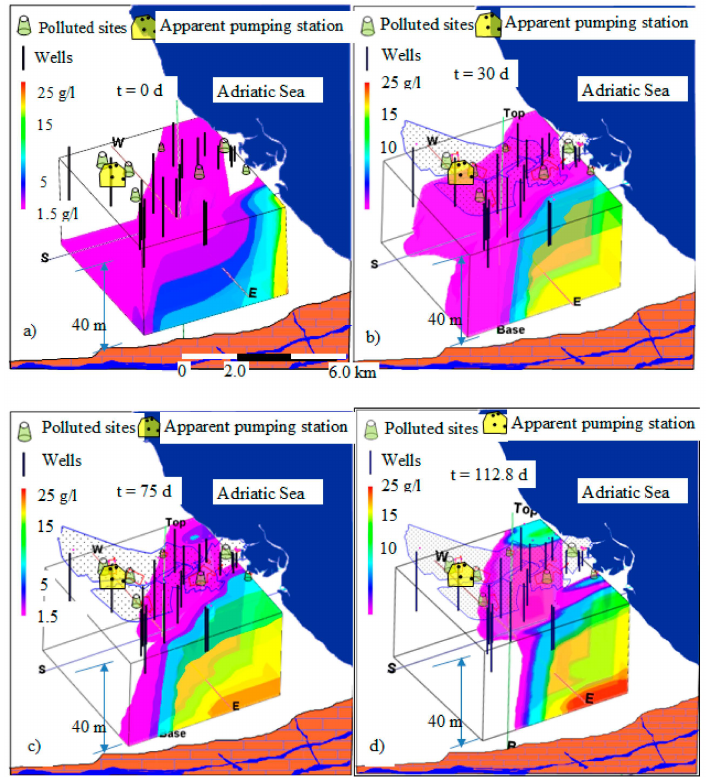
Figure 8. ( a ) 3D map of groundwater salinity during winter 2012 ( t = 0 day) and its comparison with groundwater salinity maps after ( b ) 30; ( c ) 75 and ( d ) 112.8 days of a simulated continuous pumping of 335 L ¨ s ´ 1